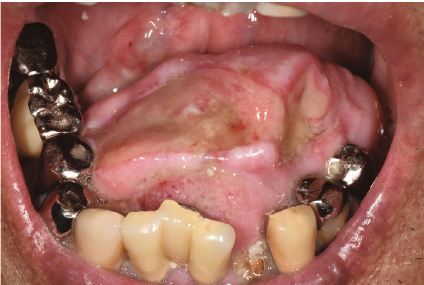
Figure 1: Intraoral photograph showing a large mass occupying the oral fl oor. The overlying oral mucosa is partially ulcerated.